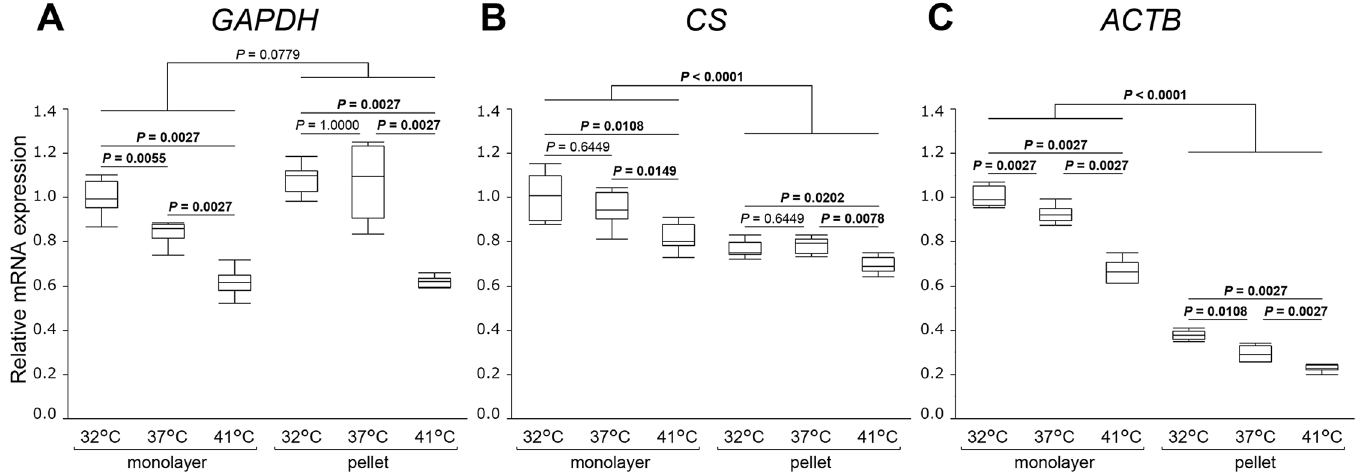
Fig 3. Chondrocyte metabolism-related gene expression. GAPDH (A), CS (B), and ACTB (C) relative mRNA expression was measured at three different culture temperatures in monolayer and pellet culture systems. Values are expressed as median and interquartile range. n = 8 dishes or pellets/group. Significantly different values ( P < 0.05) are written in